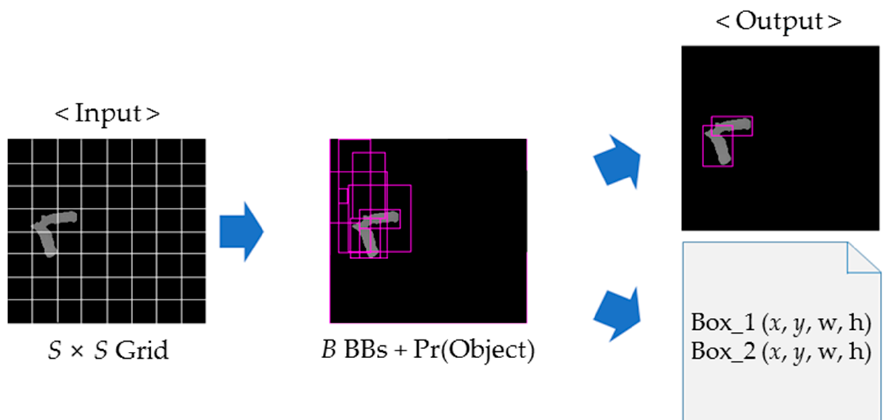
Figure 4. Selection of two useful bounding boxes (BBs) using YOLO.